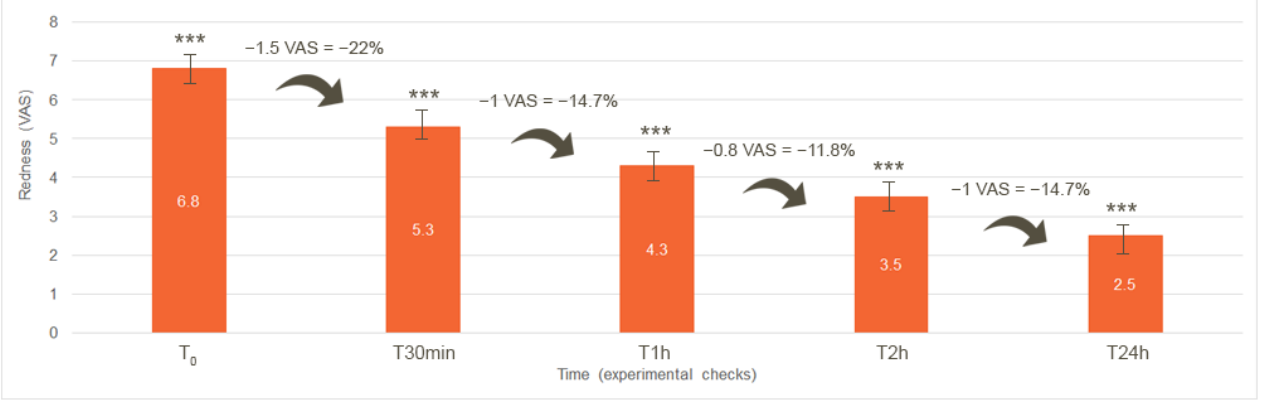
Figure 4. Evaluation of redness after sunburn (VAS score) after application of FC 16419 (Data are reported as mean ± SEM). Asterisks in the graph report the intra-group (vs. T 0 ) comparison; Legend (significance): *** p < 0.001.